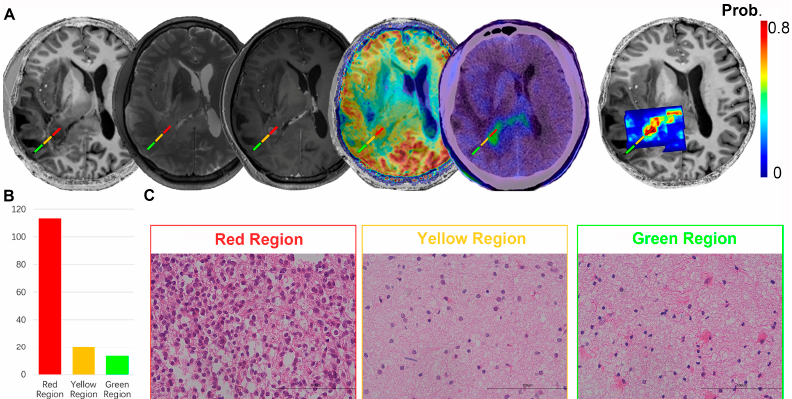
Figure 5. Probability maps of the tumor presence using APT-CEST/MRS combination. ( A ) T1-weighted, T2-weighted, contrast-enhanced T1-weighted, APT-weighted MR images, FET-PET images, and the probability mapping of tumors (possibility from 0 to 0.8) in a 41-year-old male with an IDH2 mutant oligodendroglioma (WHO Grade II). ( B ) Cell density counts were performed in 3 biopsy regions. ( C ) The histopathologic results of 3 biopsies (H&E stain, × 400 magnification). Red region, yellow region and green region stand for tumor core zone, perilesional zone and normal zone,